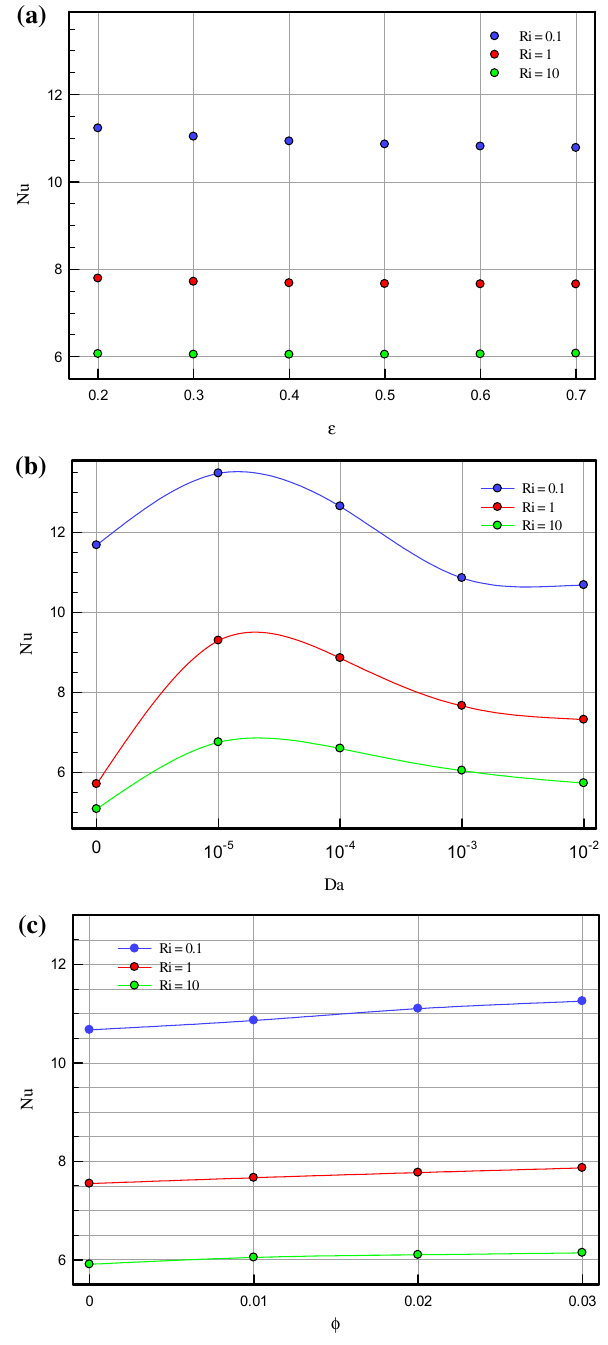
Figure 5. ( a ) Average Nusselt number for Da = 10 –3 , = 0.01, τ = 0.1. ( c ) Average Nusselt number for Da = 10 –3 , ɛ = 0.5, τ = ϕ